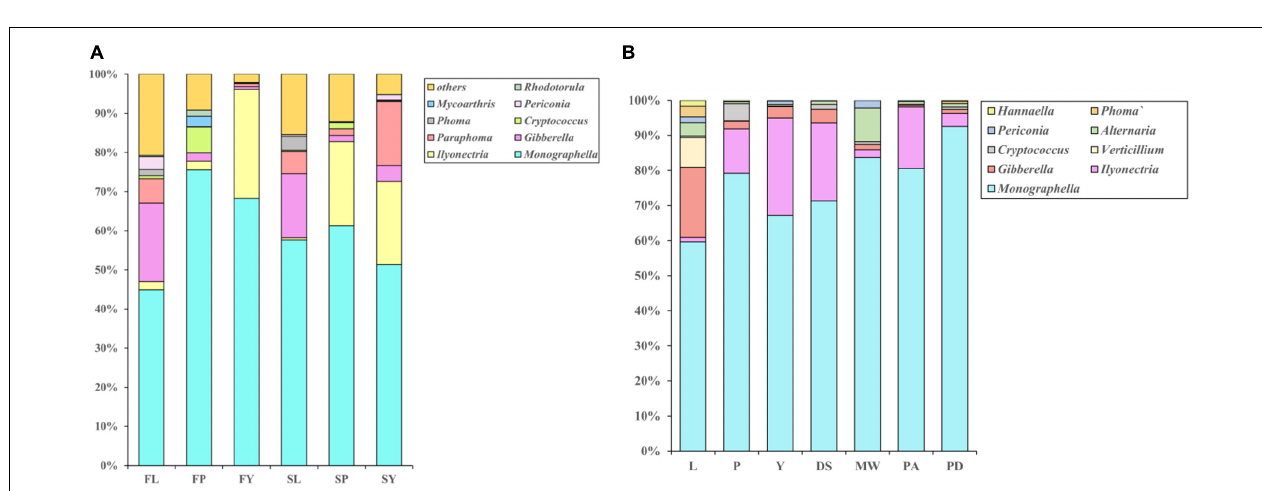
FIGURE 6 | Annotation on the community function of endophytic fungi in L. chuanxiong. FL refers to the LZ in the first cultivation cycle; FP refers to the PX in the first cultivation cycle; FY refers to the CX in the first cultivation cycle; SL refers to the LZ in the second cultivation cycle; SP refers to the PX in the second cultivation cycle; SY refers to the CX in the second cultivation cycle.